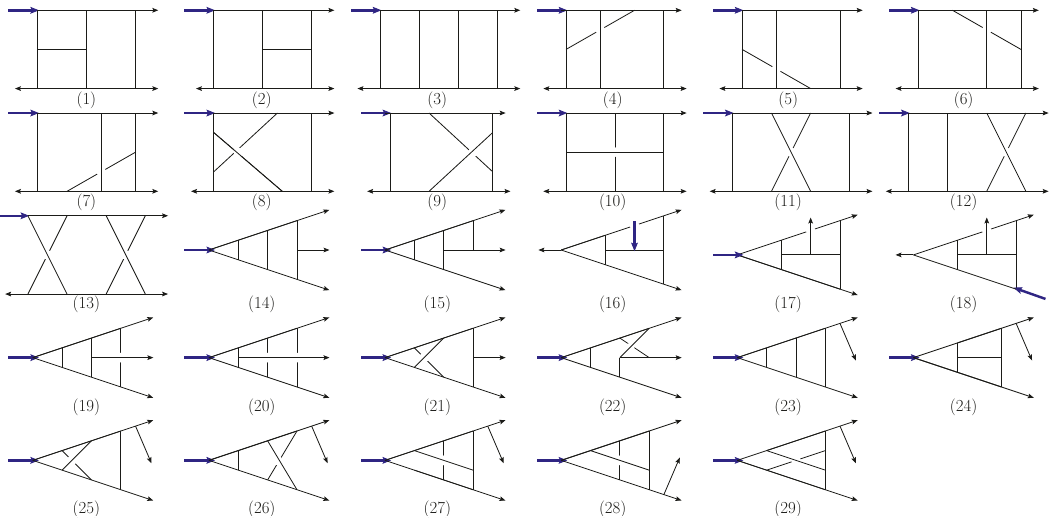
Figure 10. Trivalent topologies for the three-loop form factor of tr( φ 2 ) .